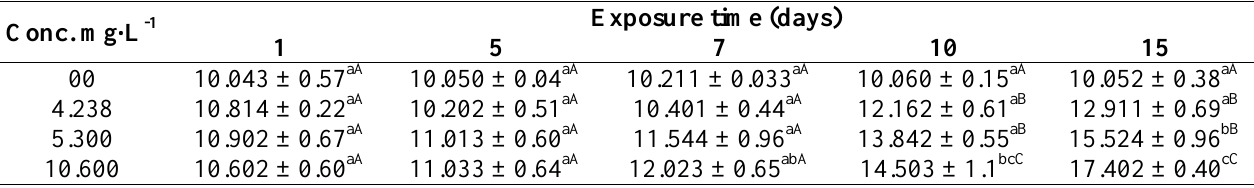
Table 7. Activity of glutathione reductase (nmol/mg protein) in the liver of C. punctatus exposed to sub-lethal doses of Atrazine for 1–15